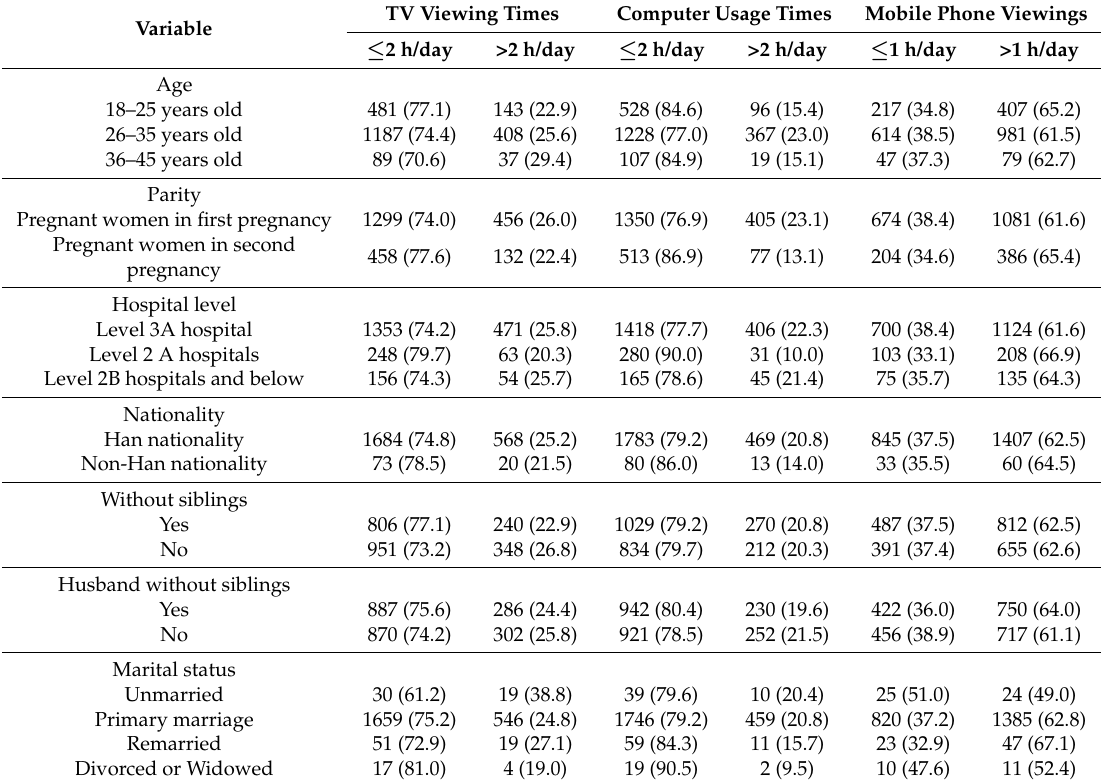
Table 3. TV viewing, computer using and mobile phone usage times among pregnant women, China, 2015 ( n ,